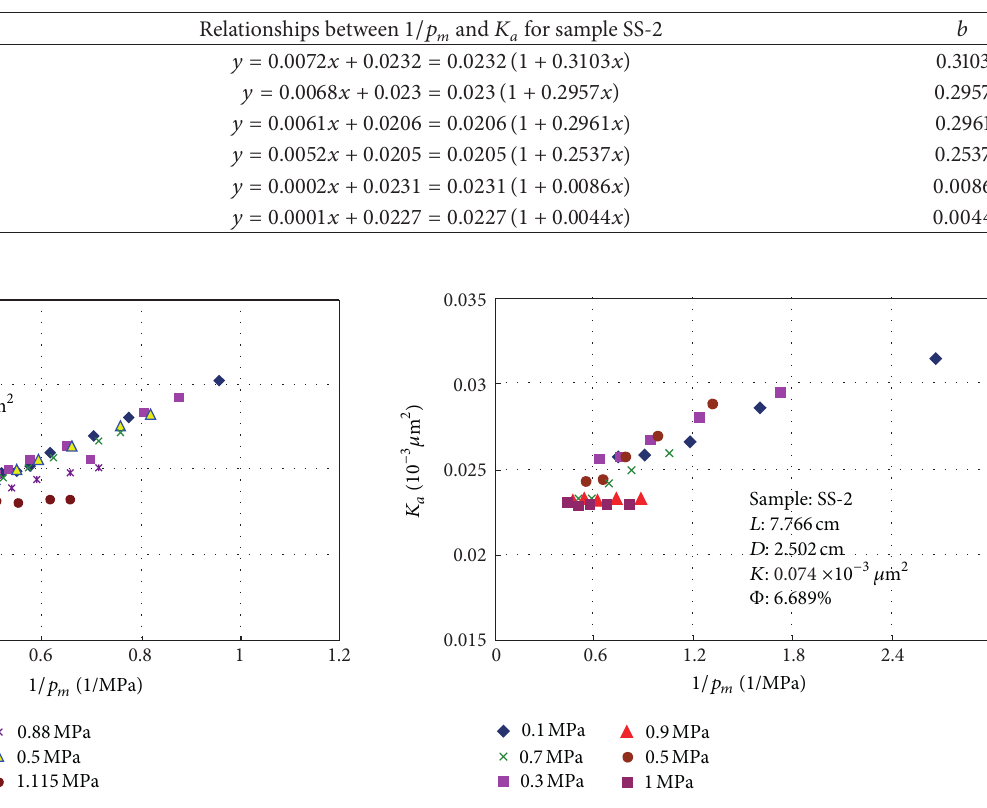
Table 3: The influence of backpressure on gas slip factor for sample SS-2.